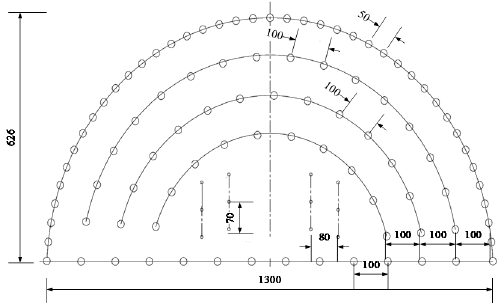
Figure 6. Layout of the blast hole (unit: cm).